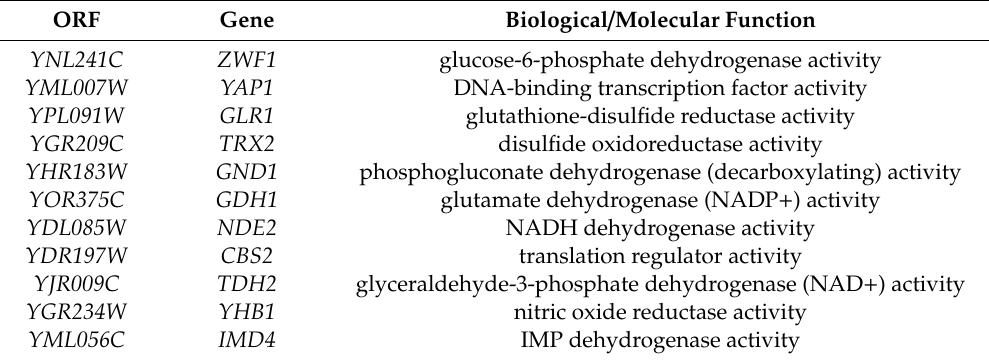
Table 1. Names and functions of genes mutated in strains showing hypersensitivity as compared to the wildtype against compounds 1 and 2